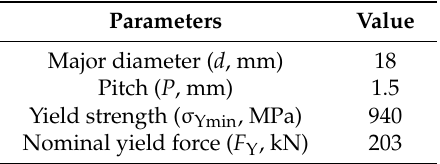
Figure 2. Materials used in this work: ( a ) a bolt and nut, ( b ) a hub assembly with six bolts, and ( c ) a truck wheel placed onto the hub assembly in ( b ). Table 1. Specifications of the bolt used in this work.